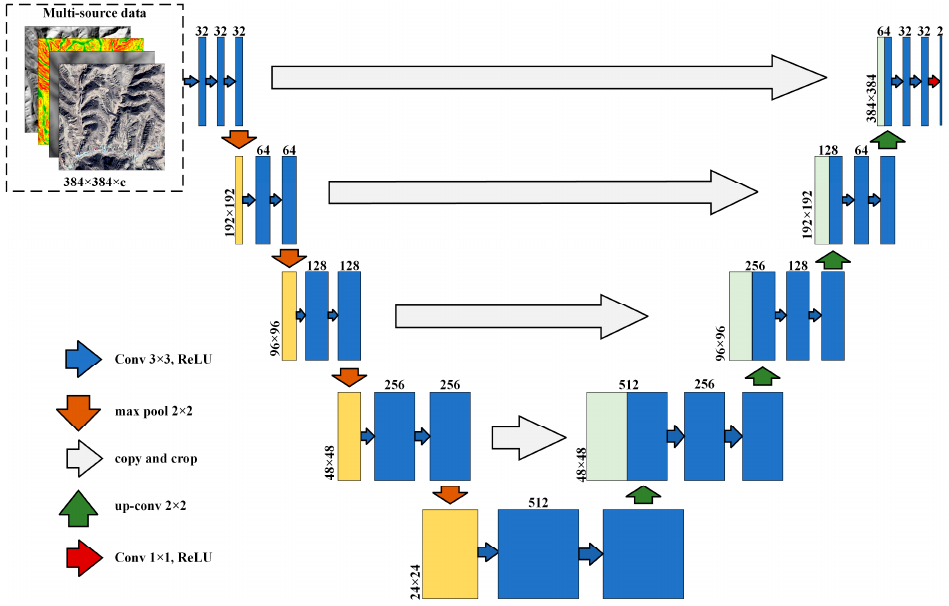
Figure 5. The structure of the